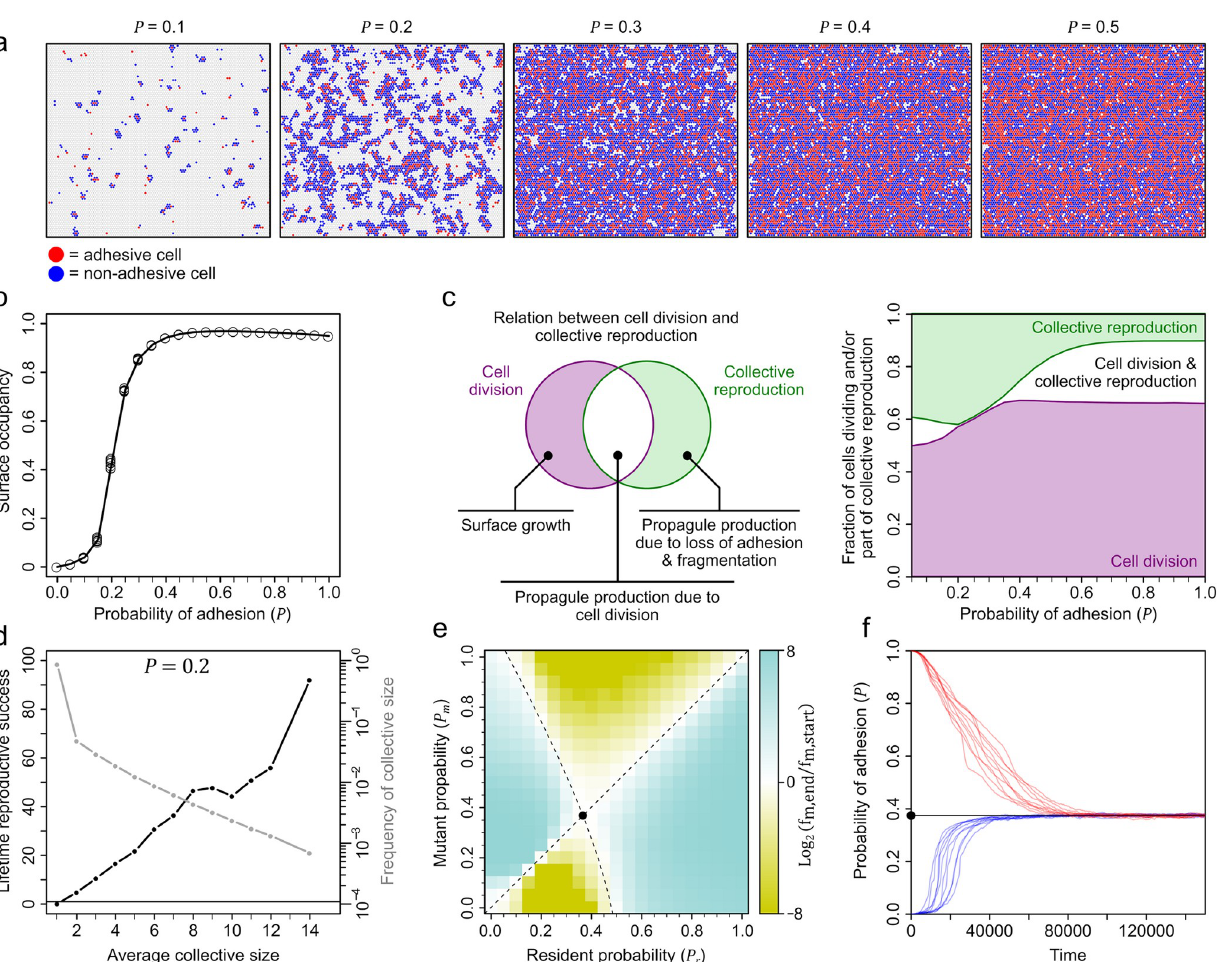
Fig 2. Relation between adhesion probability and collective properties. (a) Surface with adhesive (red) and nonadhesive (blue) cells at different adhesion probabilities. (b) Relation between surface occupancy and adhesion probability ( n = 10). (c) Left, Venn diagram showing the conceptual relationship between cell division and collective reproduction: purple, cell division without collective reproduction, which results in collective growth; white, cell division that leads to detaching propagule; green, collective reproduction without cell division (e.g., fragmentation or propagule production due to loss of adhesion). (c) Right, fraction of cells on the surface that undergo cell division and/or are part of collective reproduction. (d) Relation between lifetime reproductive success and collective size (i.e., number of cells) for P = 0.2. (e) Pairwise invasibility analysis ( n = 10, for every competition of resident and mutant genotypes): white, fitness of resident and mutant genotypes are the same; cyan, fitness of mutant genotype is higher; ocre, fitness of resident genotype higher (see S1 Text). Black dot, adhesion probability ( P � ) favored in competition. Dashed lines show isoclines where resident and mutant genotypes are equally fit. (f) Evolution of adhesion probability in populations starting from P = 0 (blue lines; n = 10) and P = 1 (red lines; n = 10). Black vertical line: P � . Raw data are provided in S2 Data in Github repository https://github.com/jordivangestel/PLoS-Biology-2021.